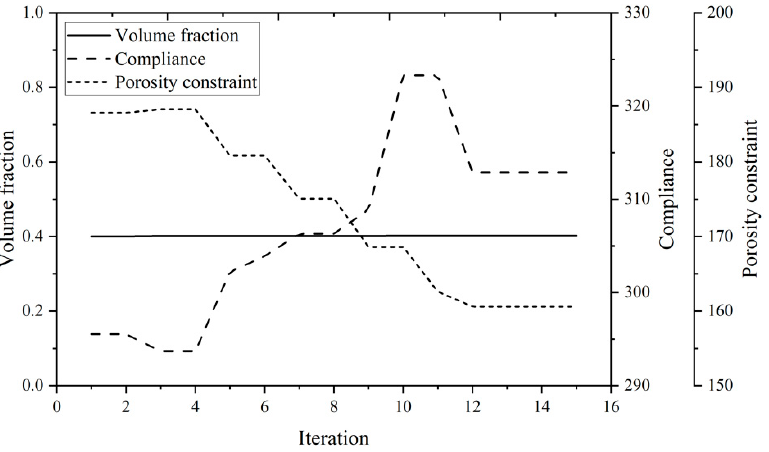
17 of 21 Figure 9. Preliminary optimized shape of C-shaped bracket. Figure 10. Convergence history of C-shaped bracket by hole nucleation method.